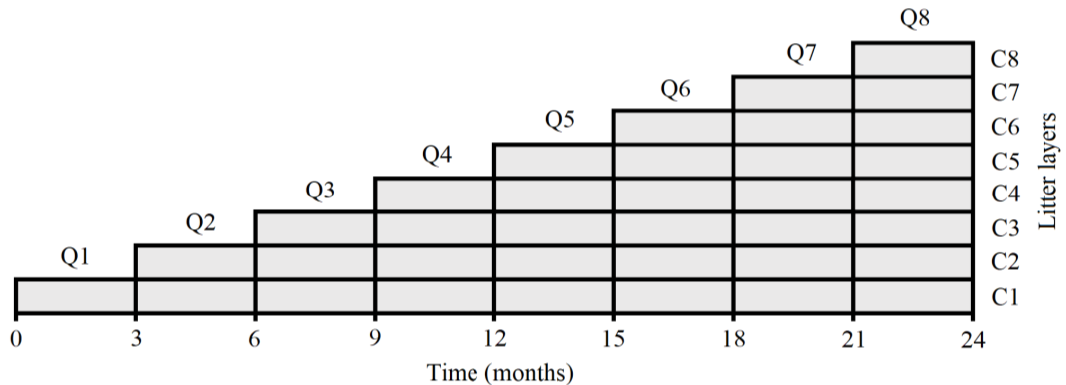
Figure 1. Schematic representation of the sampling procedure used during the study. Q: sampling quadrant.